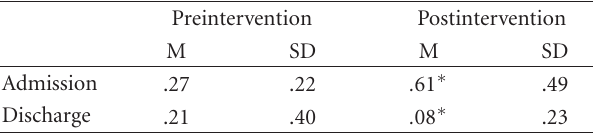
Table 3: Alarm distress baby scale.